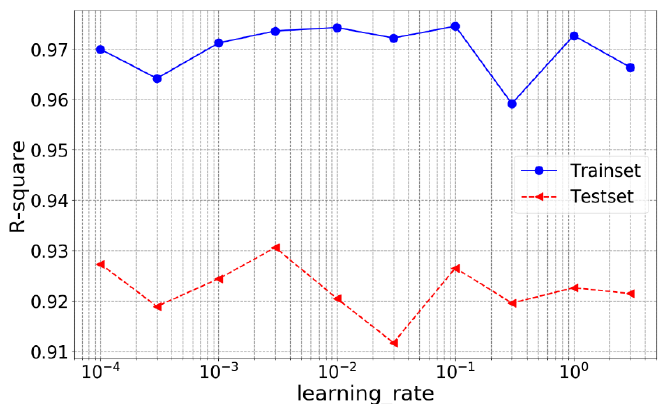
Figure 13. R-square of ANN with different learning rate.